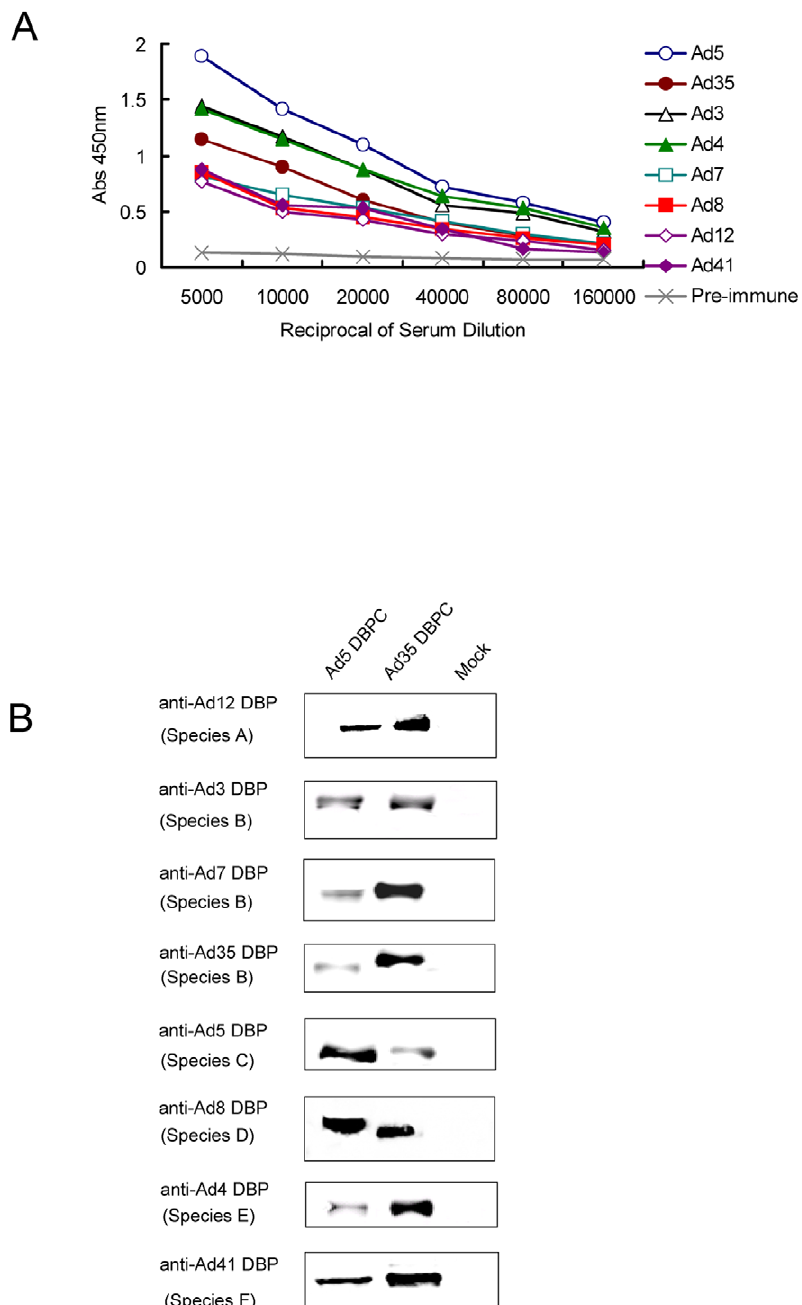
Figure 3. Antigenic characterization of DBPs of different HAdV species. (A) Titers of IgG antibody against different HadV species [species A (Ad12), species B (Ad3, Ad7, and Ad35), species C (Ad5), species D (Ad8), species E (Ad4), and species F (Ad41)] in mice sera were analyzed. The titers of mice sera were determined as a series of two-fold dilutions by ELISA. (B) The immunological cross-reactivity was analyzed between Ad5 DBPC/ Ad35 DBPC and anti-Ad12 DBP, anti-Ad3 DBP, anti-Ad7 DBP, anti-Ad35 DBP, and anti-Ad5 DBP, anti-Ad8 DBP, anti-Ad4 DBP, and anti-Ad41 DBP mice serum by Western blot.